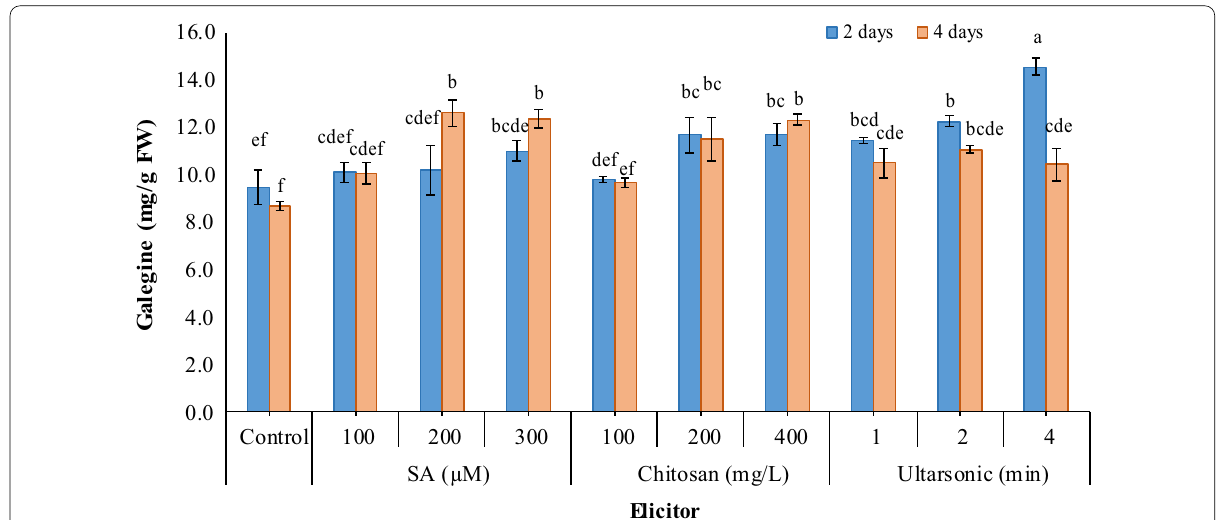
Fig. 8 Effect of different elicitors on galegine content in hairy root culture of G. officinalis. Different letters show significant differences ( p < 0.01) among